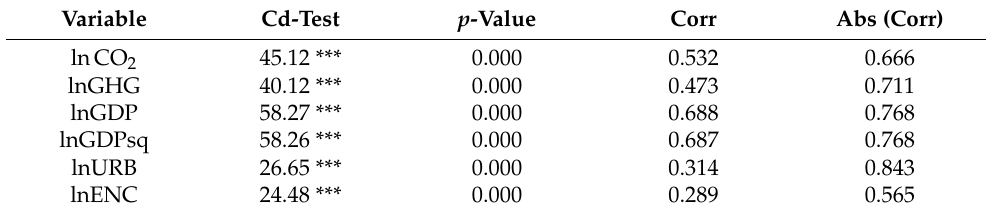
Table 3. Results of cross-sectional dependency Pesaran test.